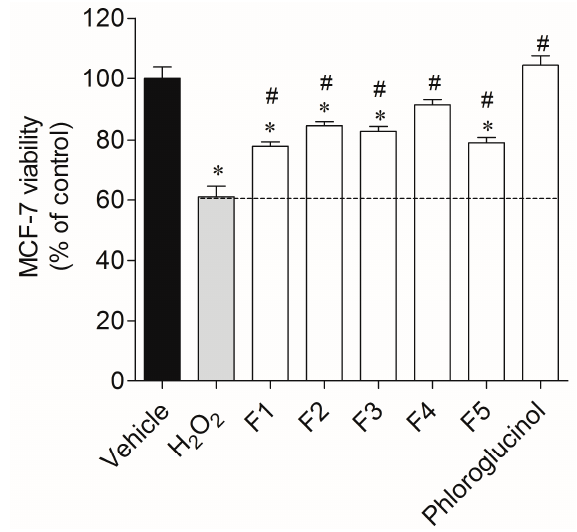
Figure 2. The effect of Fucus spiralis fractions (1 mg/mL) in an oxidative stress condition promoted by H 2 O 2 (0.2 mM), after 24 h of treatment, on MCF-7 cells. Results were obtained by the MTT method. Values in each column represent the mean ± standard error of the mean (SEM) of eight independent experiments. Symbols represent statistically significant differences ( p < 0.05, analysis of variance (ANOVA), Dunett’s test) when compared to: * vehicle and # to H 2 O 2